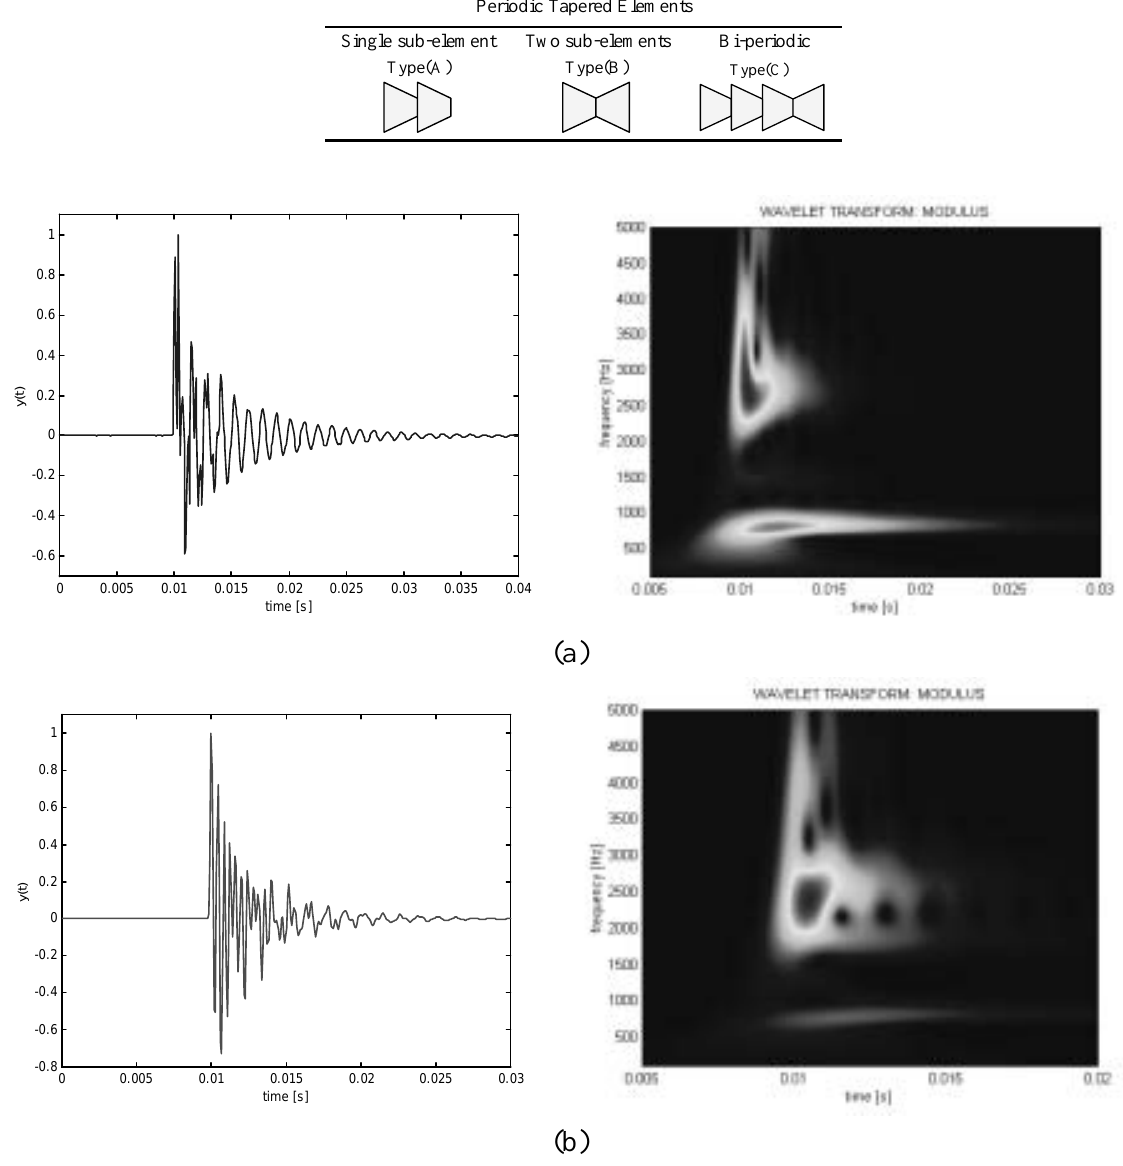
Fig. 11. Experimental Time Response and Wavelet Transform: (a) uniform thickness, (b) tapered